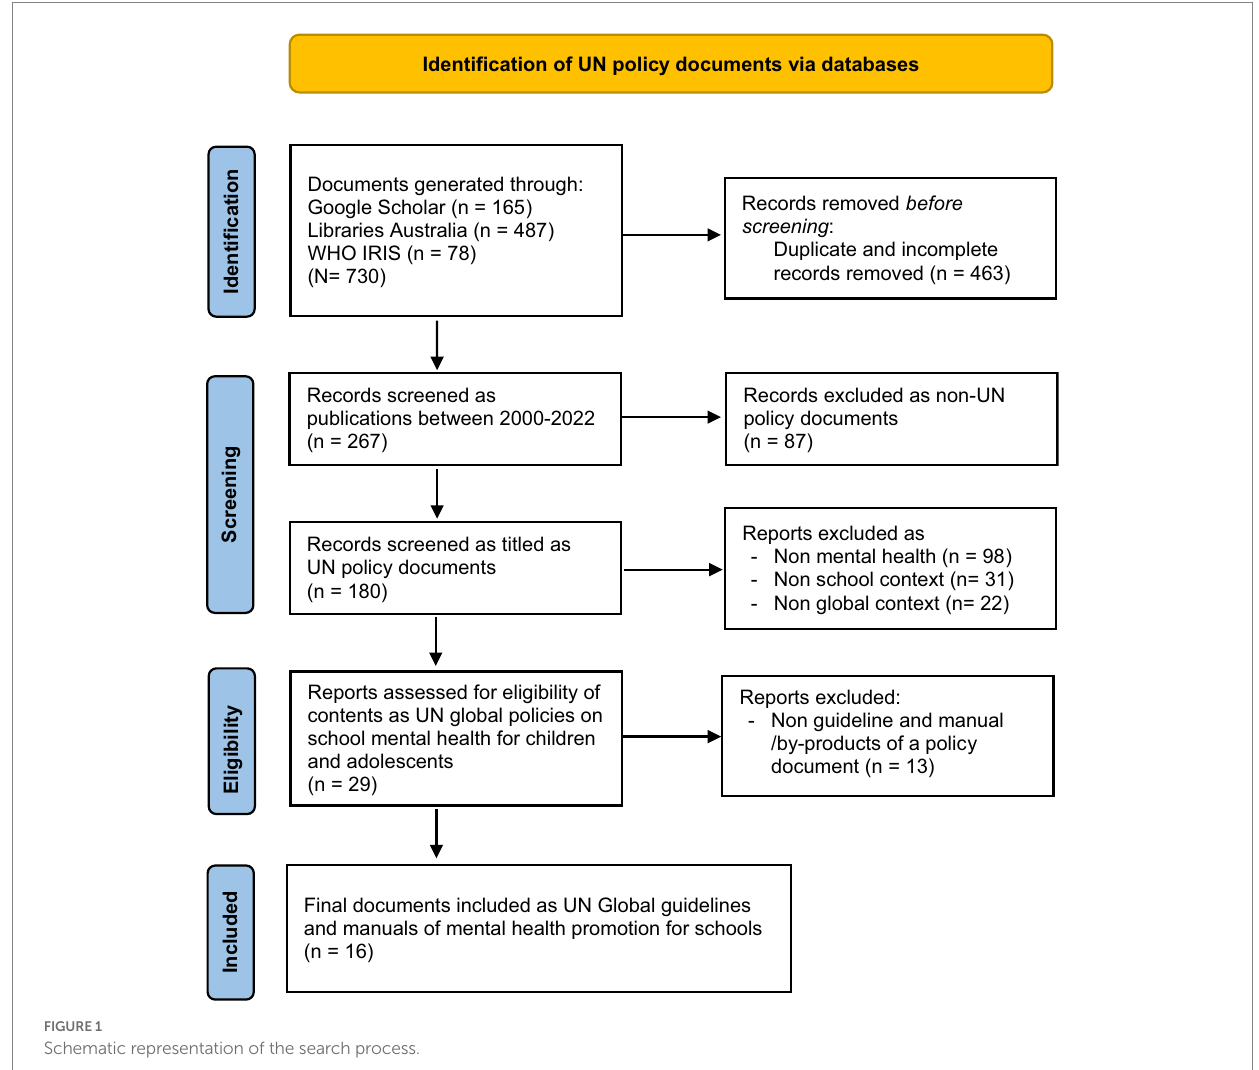
FIGURE 1 Schematic representation of the search